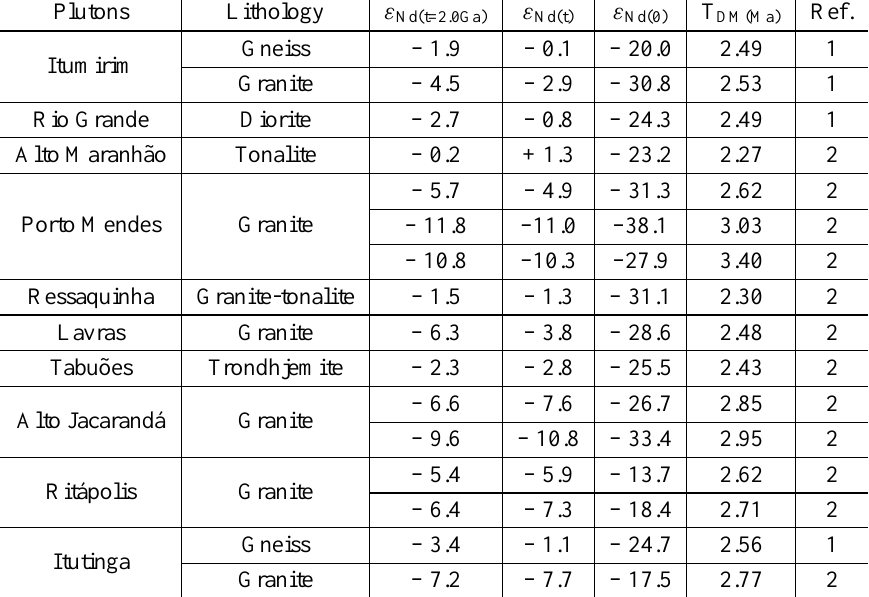
ε Nd(t) = Cristallization age as indicated in the referred